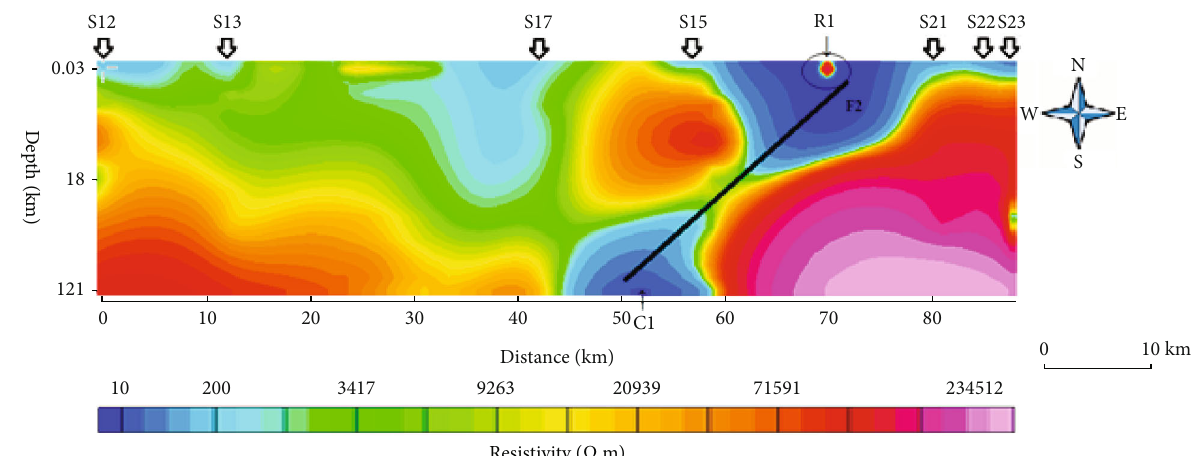
Figure 8: 2D resistivity section of pro fi le